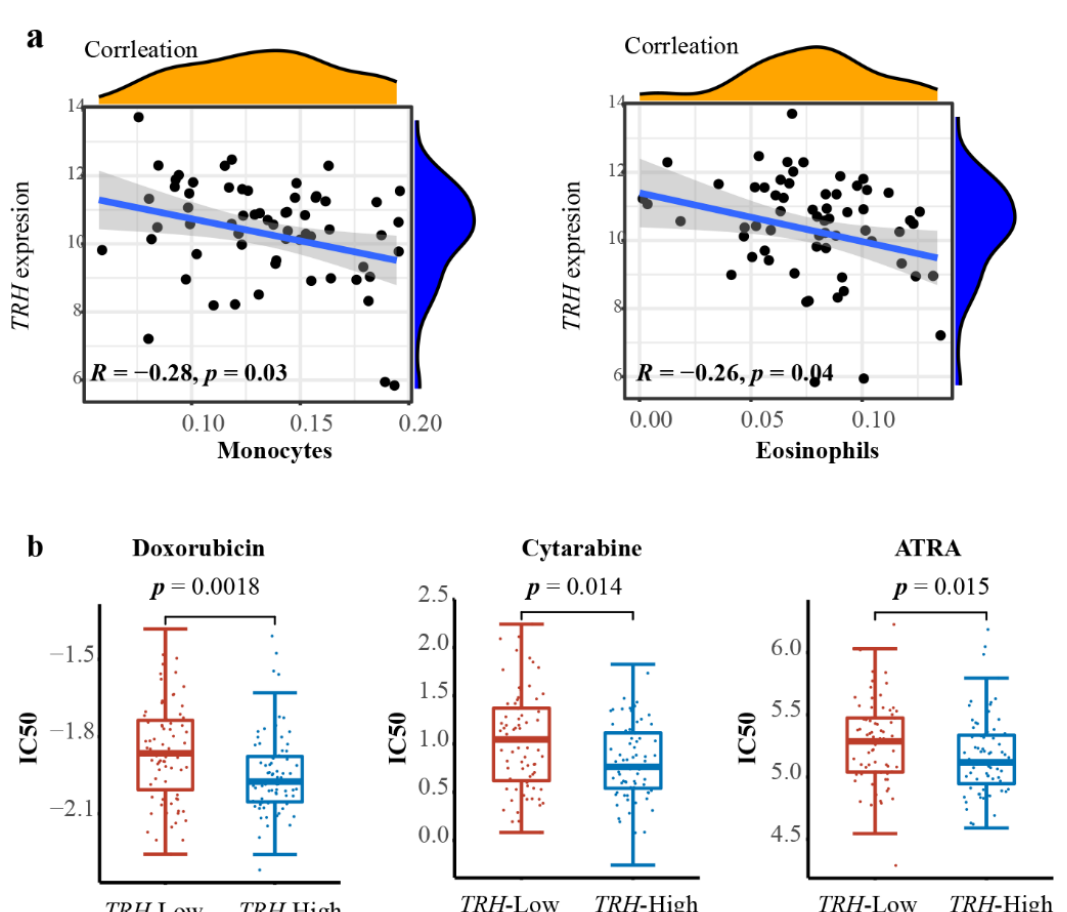
Figure 5. Immune status and drug resistance correlated with TRH expression. ( a ) Correlation analysis of TRH expression with the proportion of immune cells in RUNX1-RUNX1T1 AML patients based on the Cibersort algorithm. Spearman’s correlation analysis and correlation coefficient ( R ) are shown. ( b ) Distribution of IC50 for doxorubicin, cytarabine, and all-trans retinoic acid (ATRA) between high- and low- TRH expression groups of AML patients. Statistical significance was determined using the Wilcoxon test.